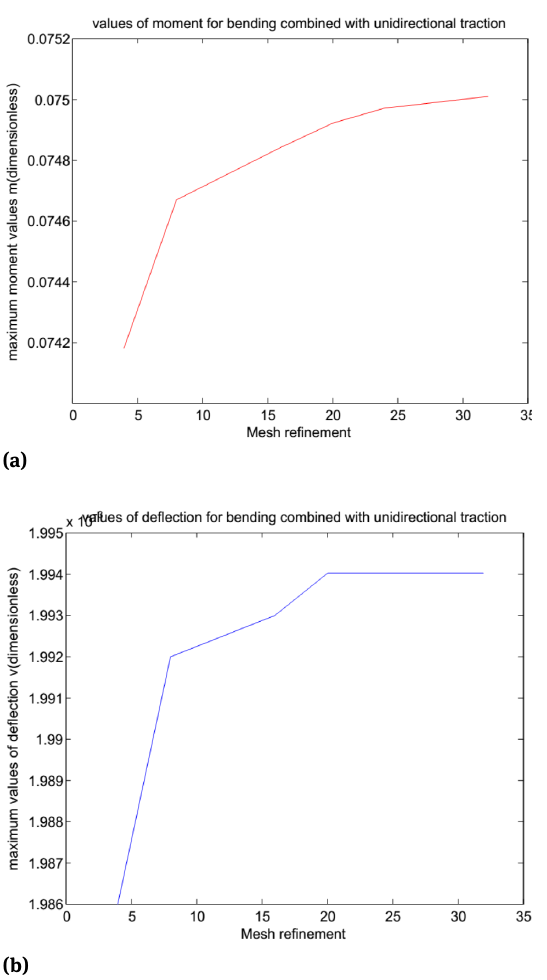
Figure 7: a) Graphical representation of the moment coeflcients; b) Ggraphical representations of coeflcients of deflection.